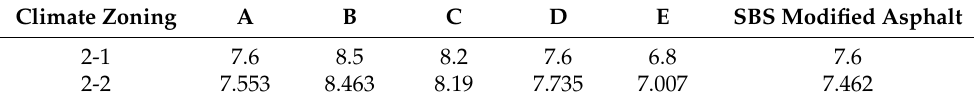
Table 14. Comprehensive evaluation results of asphalt in the two climatic zones. Climate